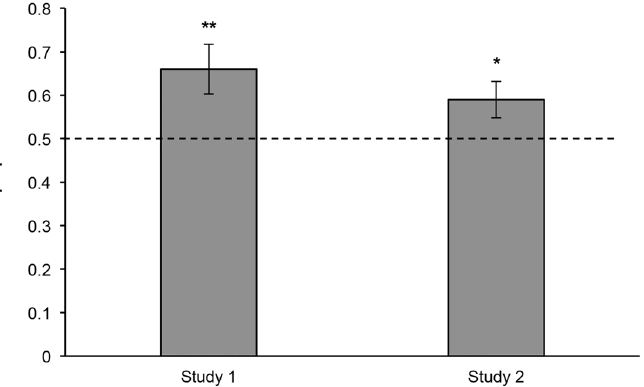
Fig 1. Mean Proportion of Trials Choosing the Formally Dressed Individual Across Studies. ** p = .01; * p = .03, as compared to chance (.50).